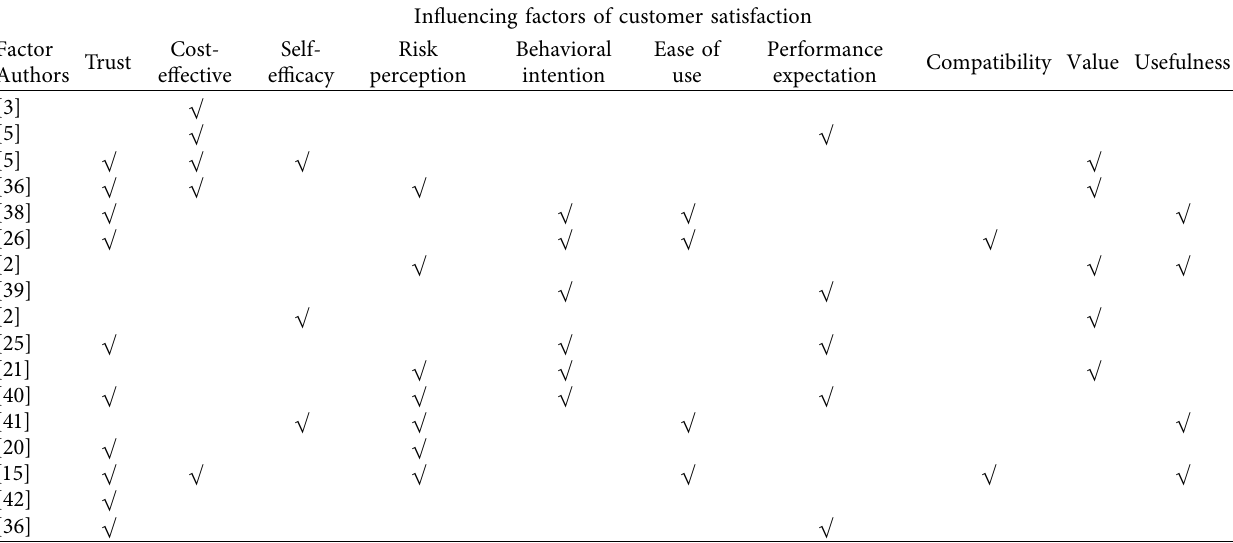
Table 1: Influencing factors of customer